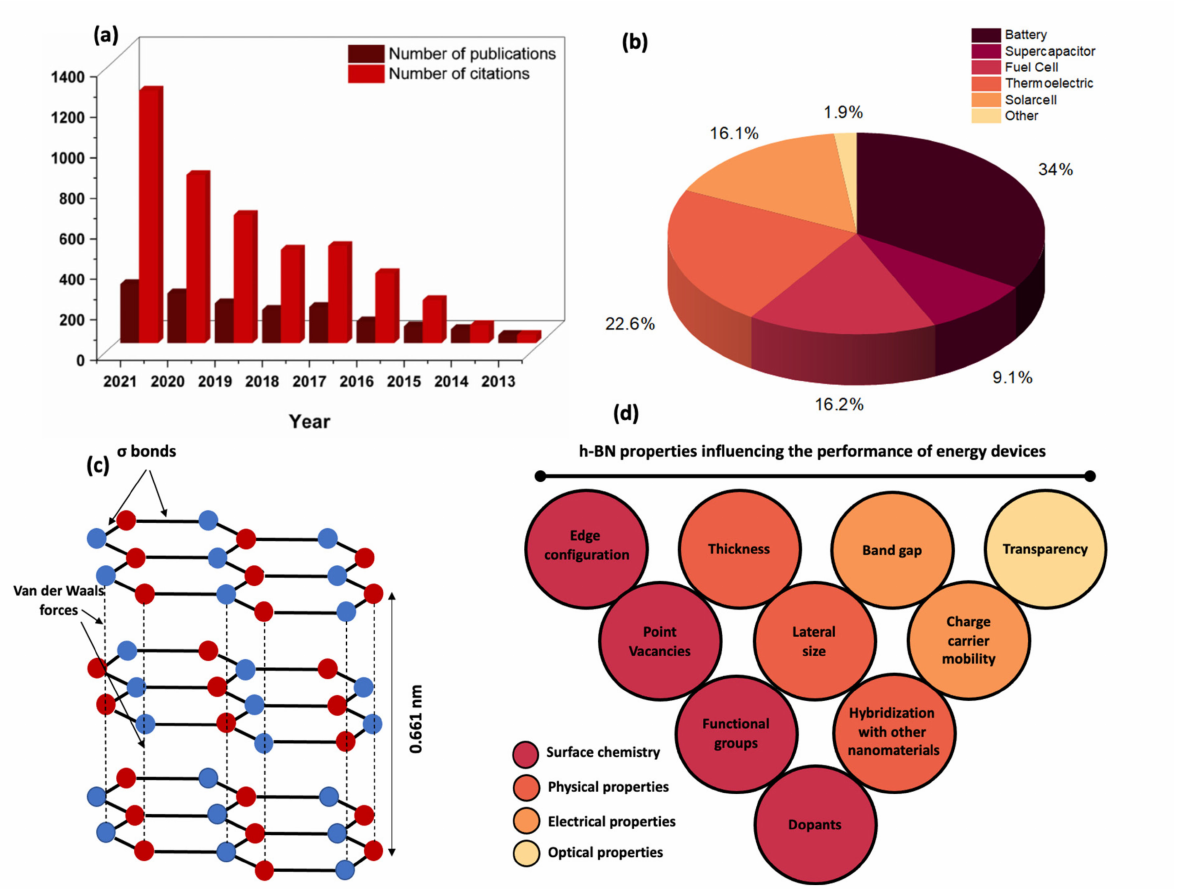
Figure 1. ( a ) The number of publications and citations on energy applications of h-BN per year based on the Scopus database. ( b ) The publication distribution pie chart of h-BN applications in energy research. ( c ) Schematic illustration of bulk h-BN crystal structure: in-plane σ bonds and cross-plane van der Waals interactions. ( d ) Diagram of h-BN characteristics that determine the overall performance of h-BN-based energy